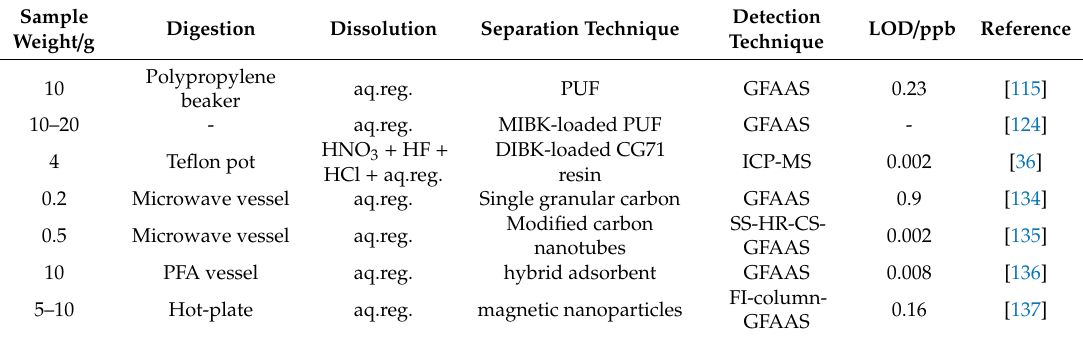
Table 6. Methods for the preconcentration of Au by PUF / extraction chromatography / novel solid absorbents. Sample Weight /